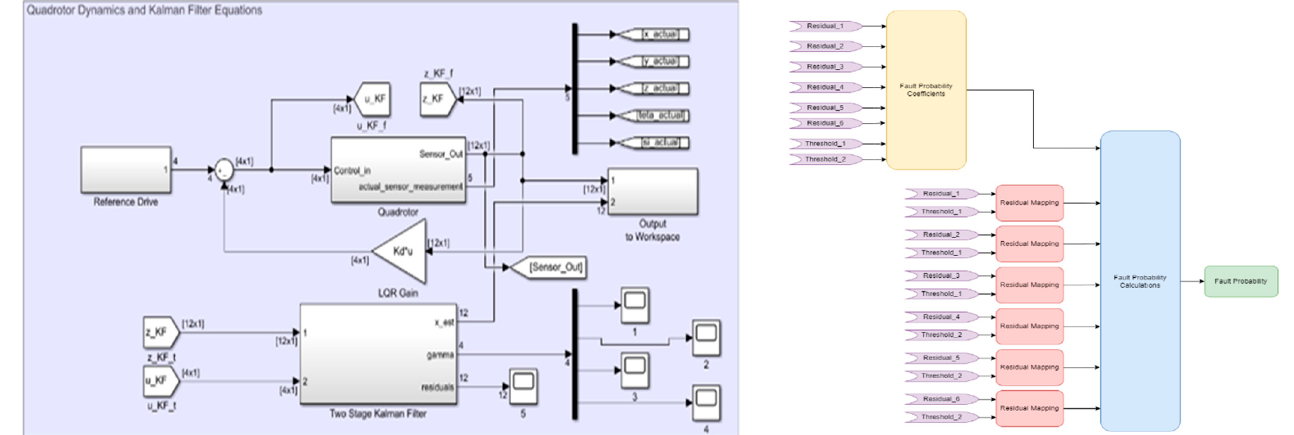
Figure 4. Quadrotor System and TSKF Equations.